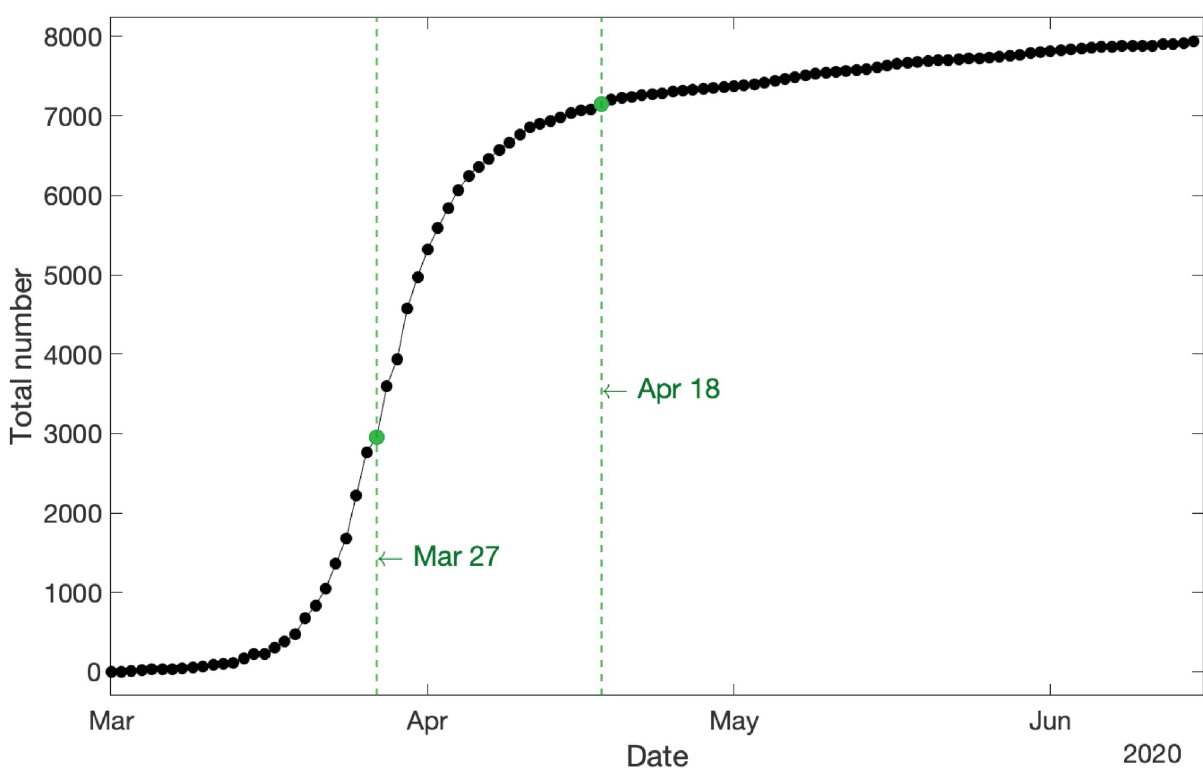
Fig 1. Cumulative new COVID-19 cases in Australia for the whole span of the data. Two structural break points in the dynamics of the COVID-19 population are evident: a major break point on 27 March 2020, and a minor break point on 18 April 2020.